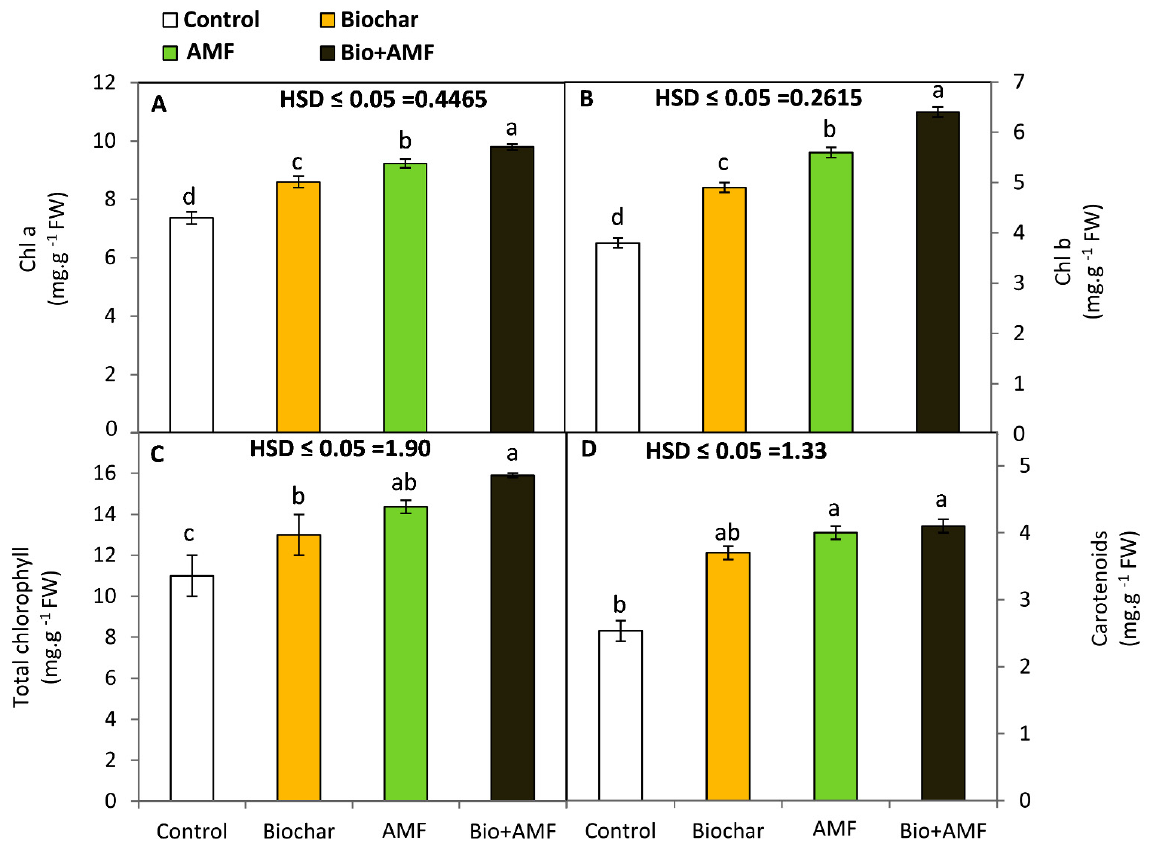
Figure 1. Impact of biochar and AMF on the photosynthetic pigments of fenugreek leaf. ( A ) Chlorophyll a, ( B ) Chlorophyll b, ( C ) Total Chlorophyll, ( D ) Carotenoid’s content. Data are means of five replicates ( n = 5), for each parameter, the mean values ± SD followed by a different letter are significantly different according to Tukey’s HSD range test at p ≤ 0.05.